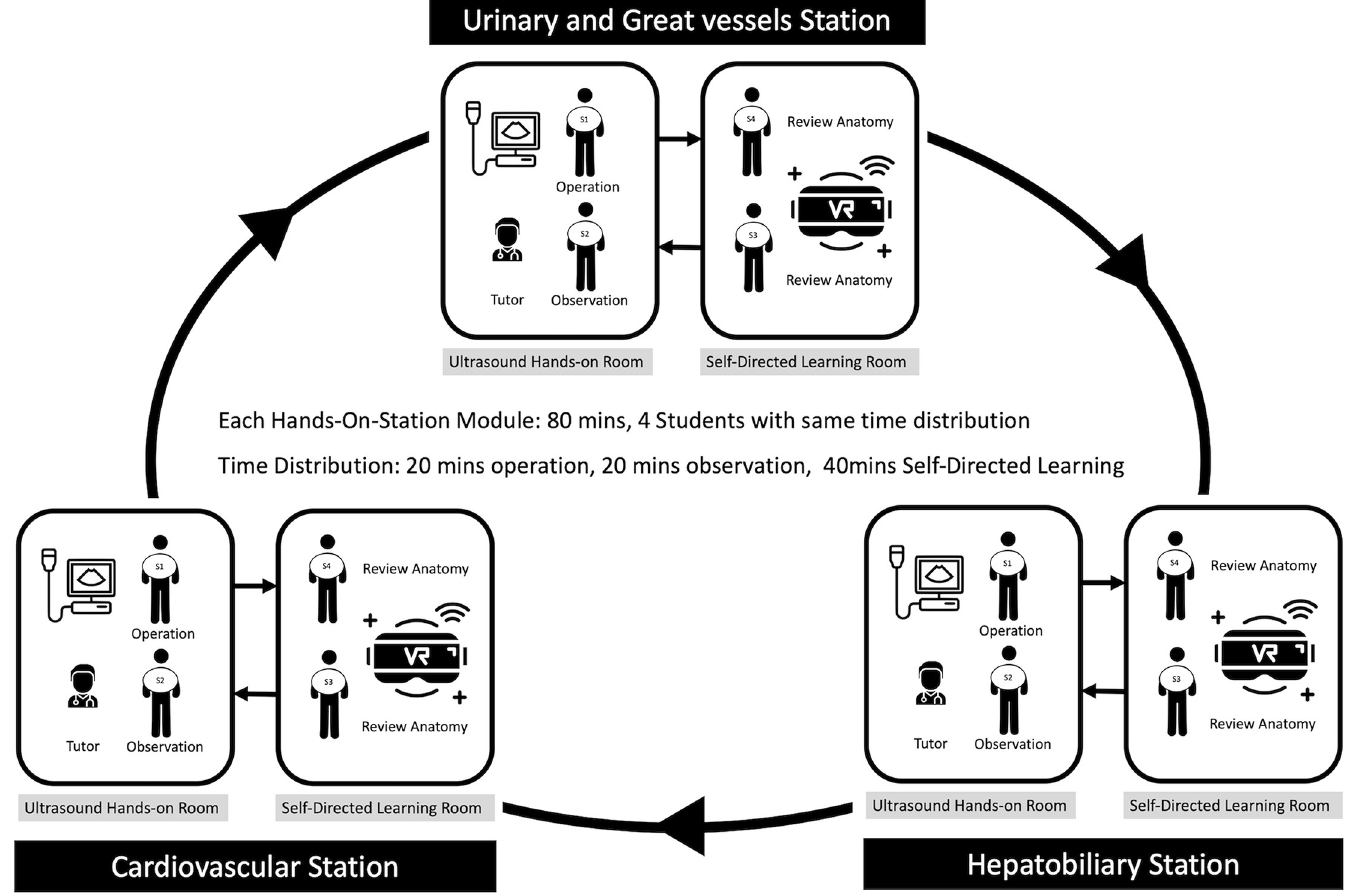
Fig 2. Time and sequence of the VR intervention